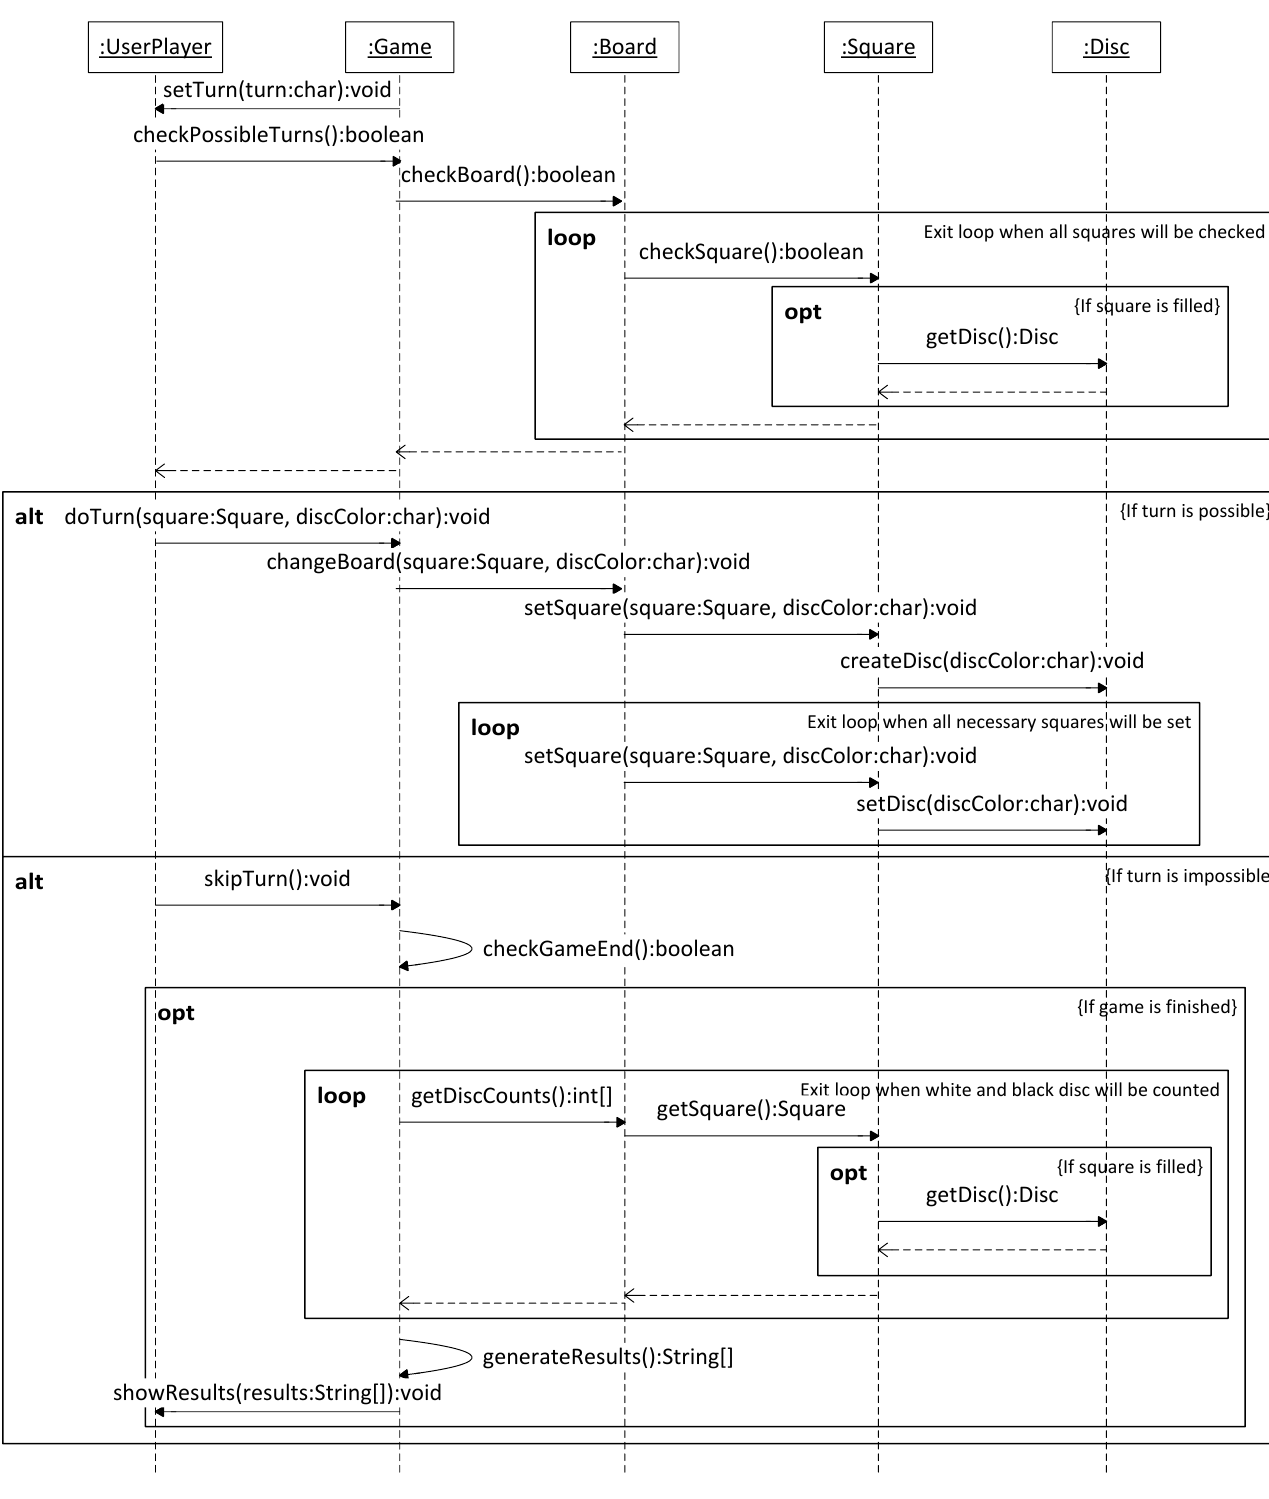
Fig. 4. The UML sequence diagram with the system goal “Do turn by a user